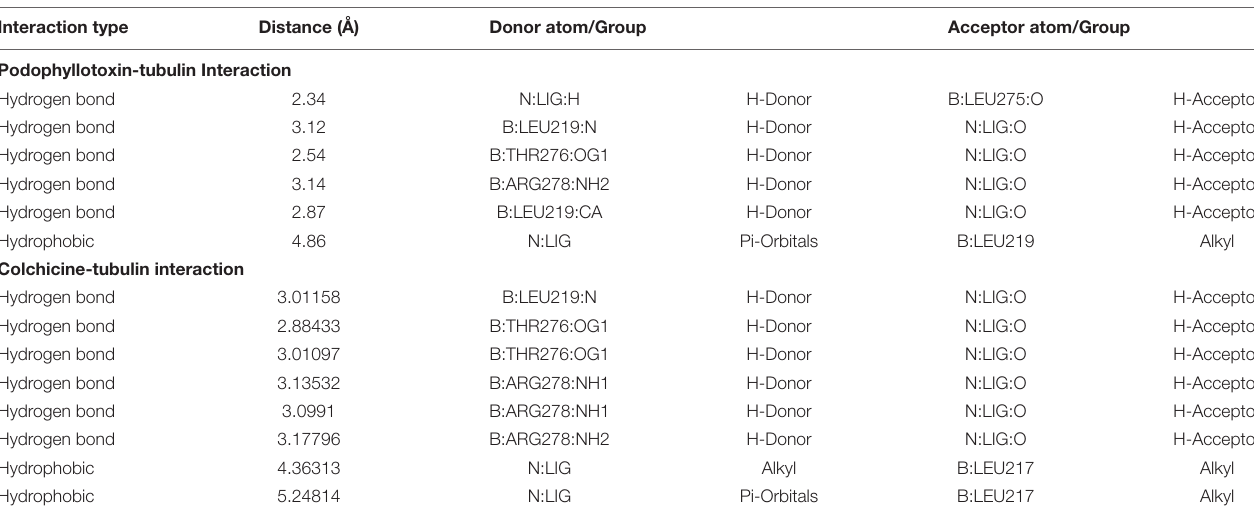
TABLE 2 | Non-covalent interaction